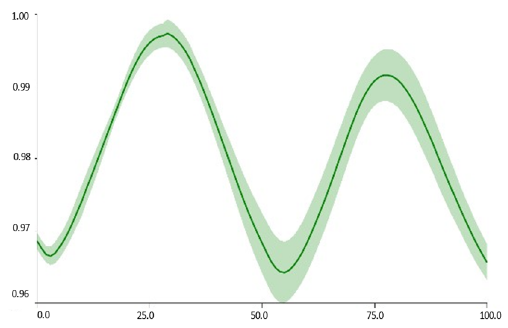
Figure 2. Kinematics of various of FF lower limb joints during gait. The Center of Mass variation over gait is illustrated in Figures 3 and 4 (NF and FF subjects respectively).